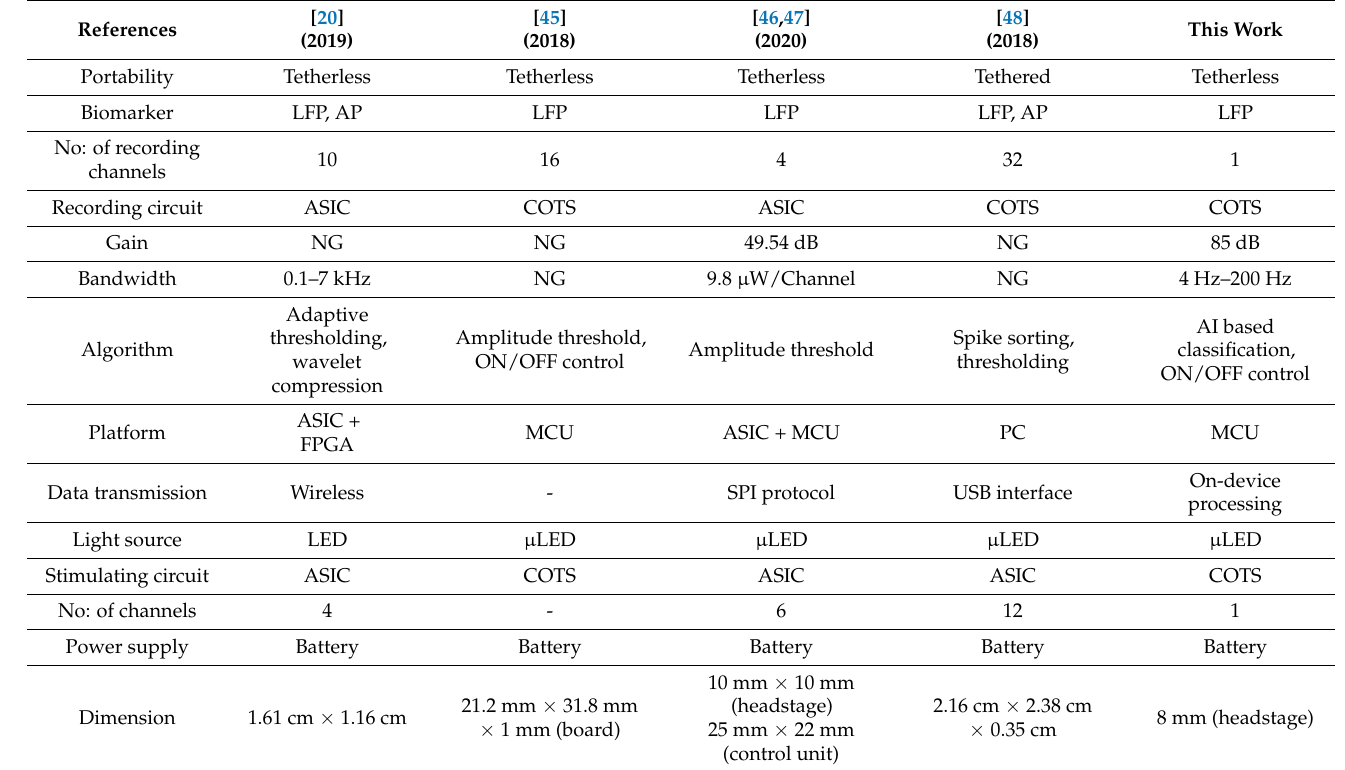
Table 3. Comparison of the component features of the presented device with existing clOBS